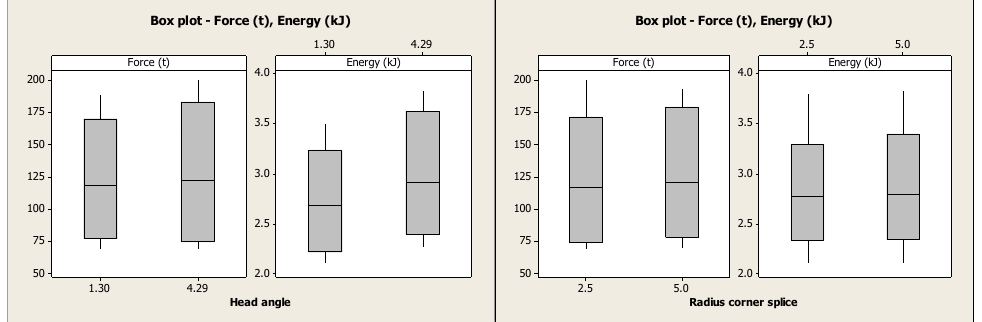
Figure 4. Box plots for geometric parameters according to the standard.